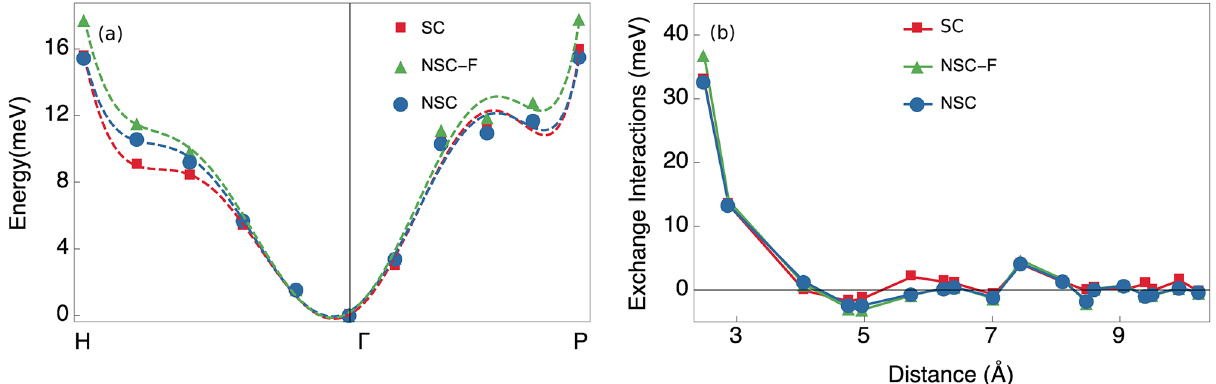
Figure 2. ( a ) Spin-spiral energy dispersion in bcc Fe. The blue circles and green triangles represent non- self-consistent total energies calculated without- (blue) and with (green) constraining fields. The red squares represent self-consistent total energies. Dashed lines represent fitted polynomials. ( b ) Exchange parameters for bcc Fe. The blue circles and green triangles represent exchange parameters calculated non-self-consistently without (blue) and with (green) constraining fields. The red squares represent exchange parameters calculated with the transverse field method.